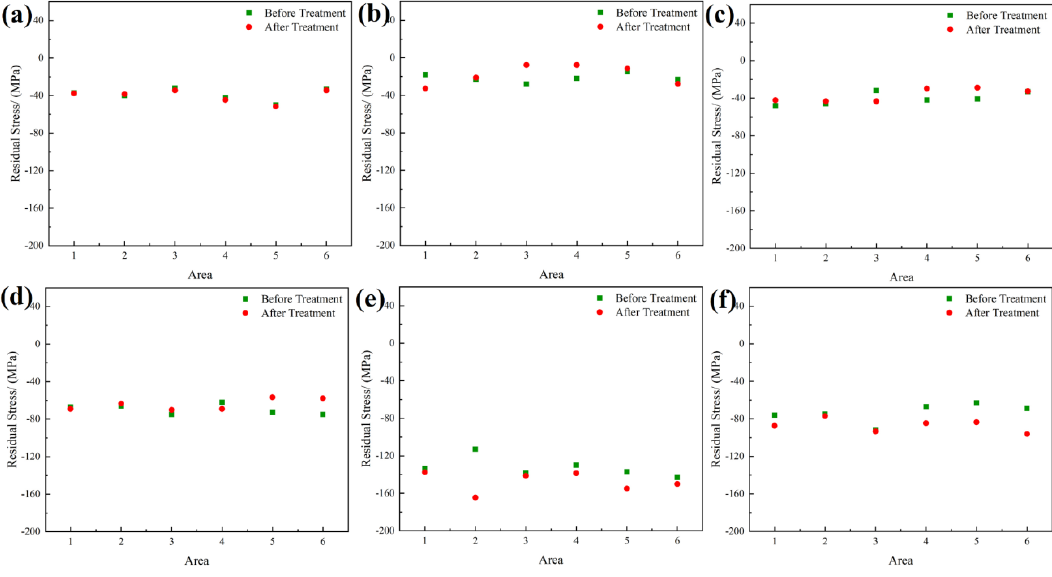
Figure 7. Residual stress before and after treatment at different magnetic fields. ( a ) 0 T; ( b ) 1.0 T; ( c ) 1.3 T; ( d ) 1.5 T; ( e ) 2.0 T; ( f ) 2.5 T.